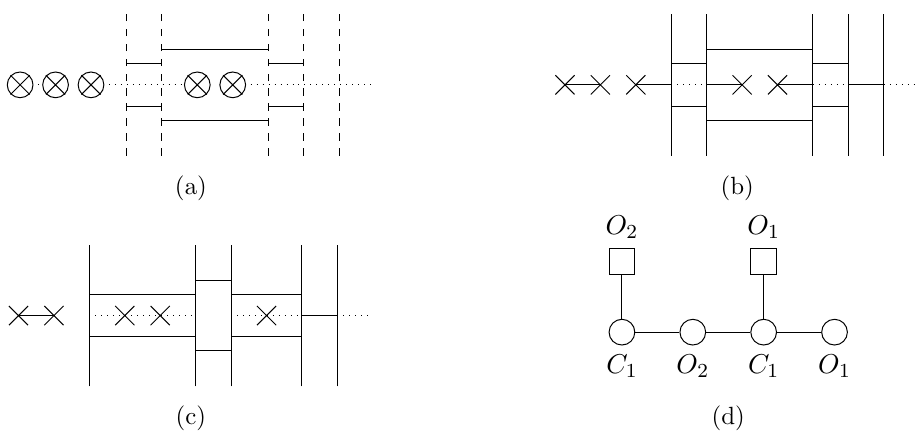
Figure 45. S-duality transformation of the model in (cid:12)gure 43(h). (a) Higgs branch of the initial model. (b) Result of performing S-duality on (a). (c) Result of performing the collapse transition on (b). (d) Quiver read from (c). The Coulomb branch of this quiver is predicted to be M C = (cid:22) O